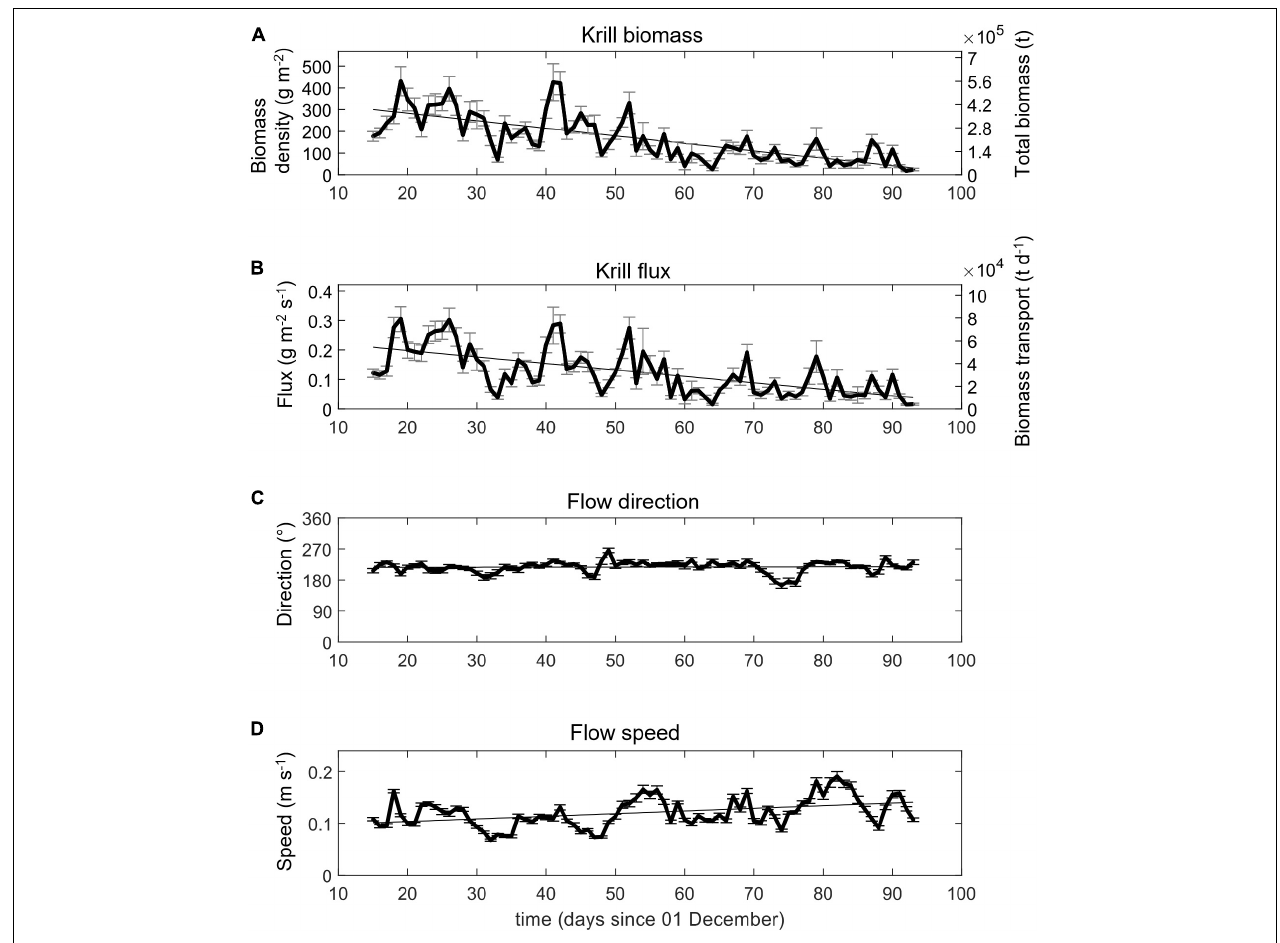
FIGURE 9 | Daily mean (A) krill biomass density (g m − 2 ) [left axis] and total biomass (t) [right axis], (B) krill flux (g m − 2 s − 1 ) [left axis] and daily mean biomass transport (t d − 1 ), (C) flow direction ( ◦ ), and (D) flow speed (m s − 1 ).